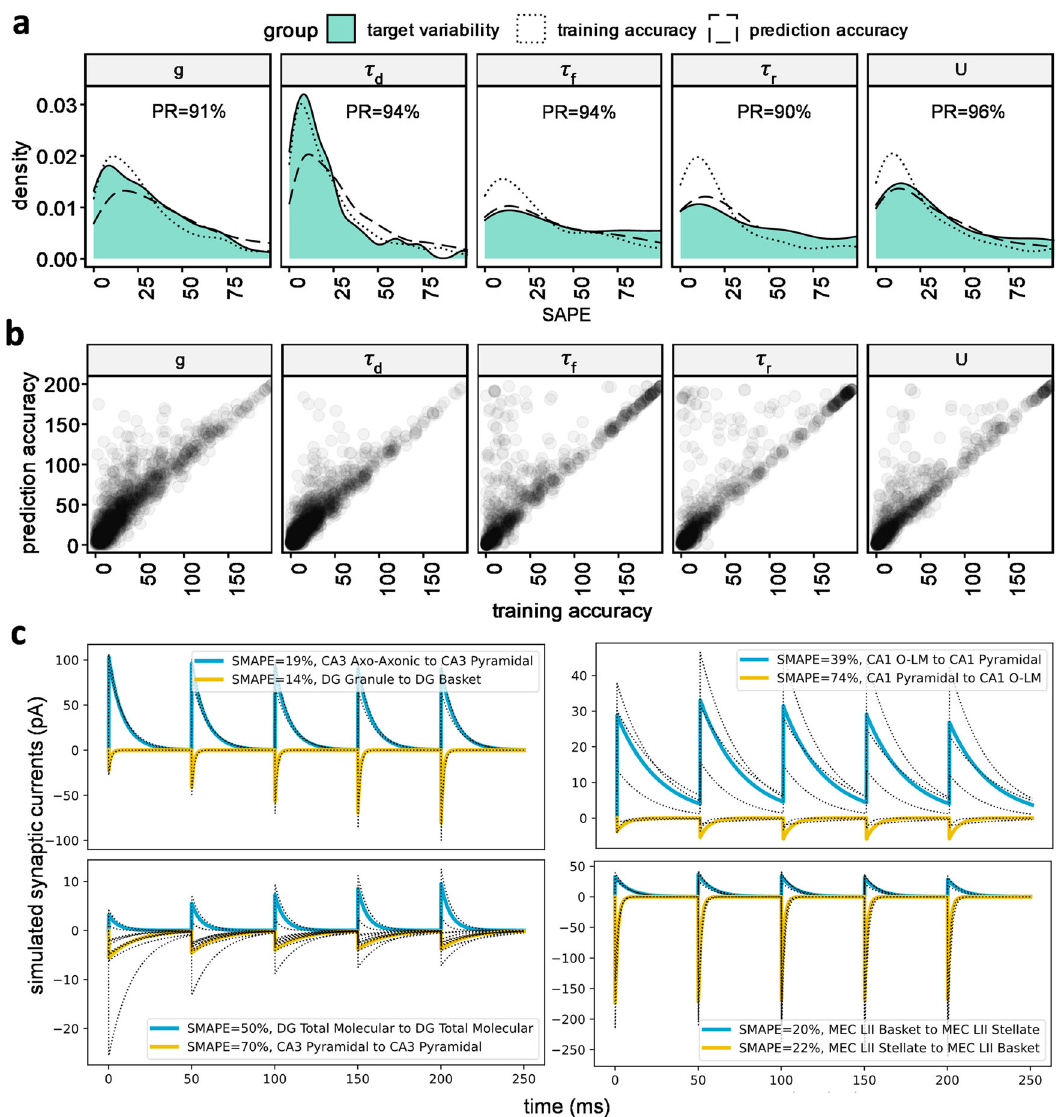
Fig. 4 Validation and representative output of the deep learning model for unitary signals. (a) Probability distribution functions of the mismatch between model output and experimental data for each of the 5 TPM parameters (targets). The mismatch is quanti fi ed by the distance, measured by symmetric absolute percentage error (SAPE), of the model output relative to targets used during training ( training accuracy ) and targets left out of training set ( prediction accuracy ). These two measures to the intrinsic variability of the available experimental data grouped based on features ( target variability ). Synapses are plastic and stochastic entities, hence if neuron pairs from the same presynaptic and postsynaptic types are recorded several times in the same conditions, several values will typically be obtained experimentally, while model outputs will be constant. In other words, target variability is the distance of a training data point from the average of targets with identical features. This measure of variability in the experimental dataset de fi nes the ideal limit of model accuracy. Training accuracy quanti fi ed the learning capacity of the model. Prediction accuracy measures the inference power of the model by calculating the distance of model output with a ground truth, which is the experimental data not seen by the model during jackknife (leave-one-out) procedure. The overall similarity of distributions indicates that the model achieved a level of accuracy comparable to the reproducibility of corresponding experimental data. The prediction reliability (PR) is the proportion of model outputs falling within the 95% con fi dence interval of the experimental data with identical features. (b) Prediction and training accuracy are highly correlated for all 5 parameters, suggesting the absence of over fi tting. (c) Simulated synaptic dynamics based on original training targets (black dotted traces) with identical features, and deep learning model inferences (solid lines). Model predictions are remarkably close to the training data even though experimental data showed variability. Simulated synaptic traces (V h = − 35 mV, GABA A E rev = − 70 mV, and AMPA E rev = 0 mV) showed a wide range of amplitudes and kinetics as well as different forms of short-term plasticity. Glutamatergic and GABAergic examples are provided for every area involved in the tri-synaptic